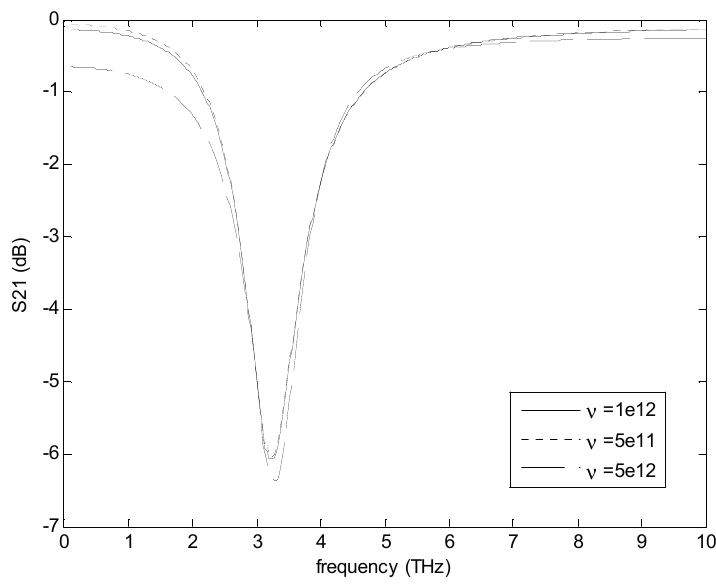
Figure 6. Modulation of the width of absorption peak in the transmission coefficient | ( ω ) | S , due to the collision 21